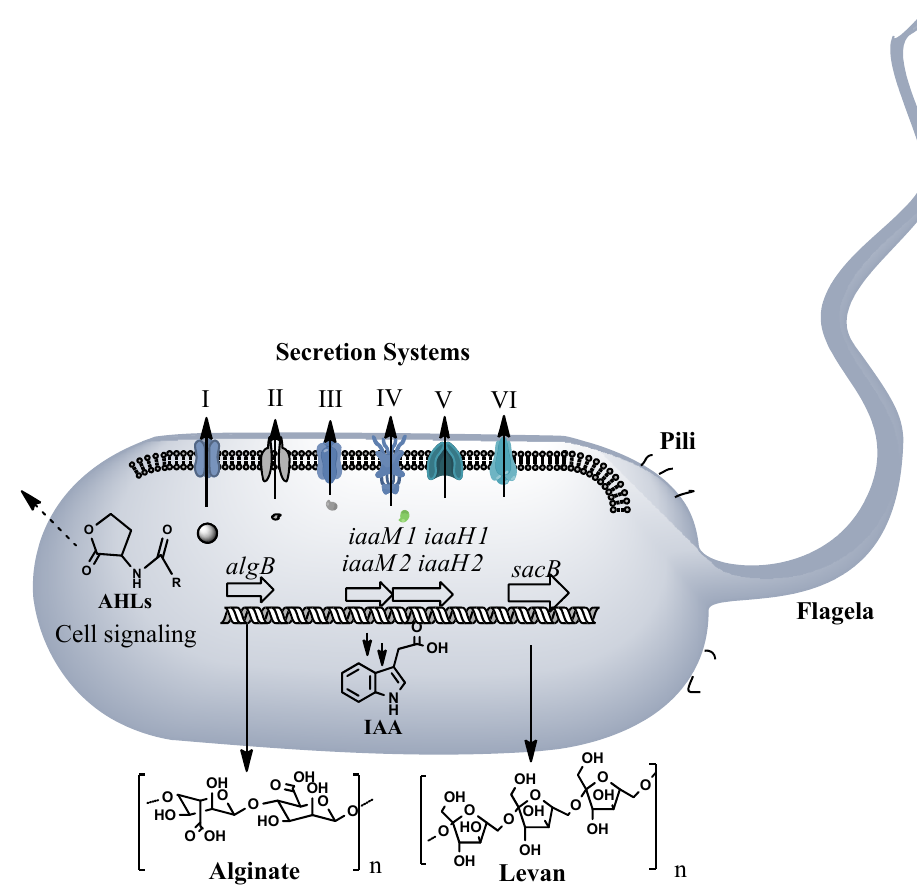
Figure 3. Pathogenicity and virulence factors of Pseudomonas ST1 strain, secretion system (I–VI), motility factors, pili and flagella, alginate and levan biosynthesis, IAA hormone biosynthesis and signaling molecule biosynthesis. For full list of conserved virulence related genes and proteins see Table S1.